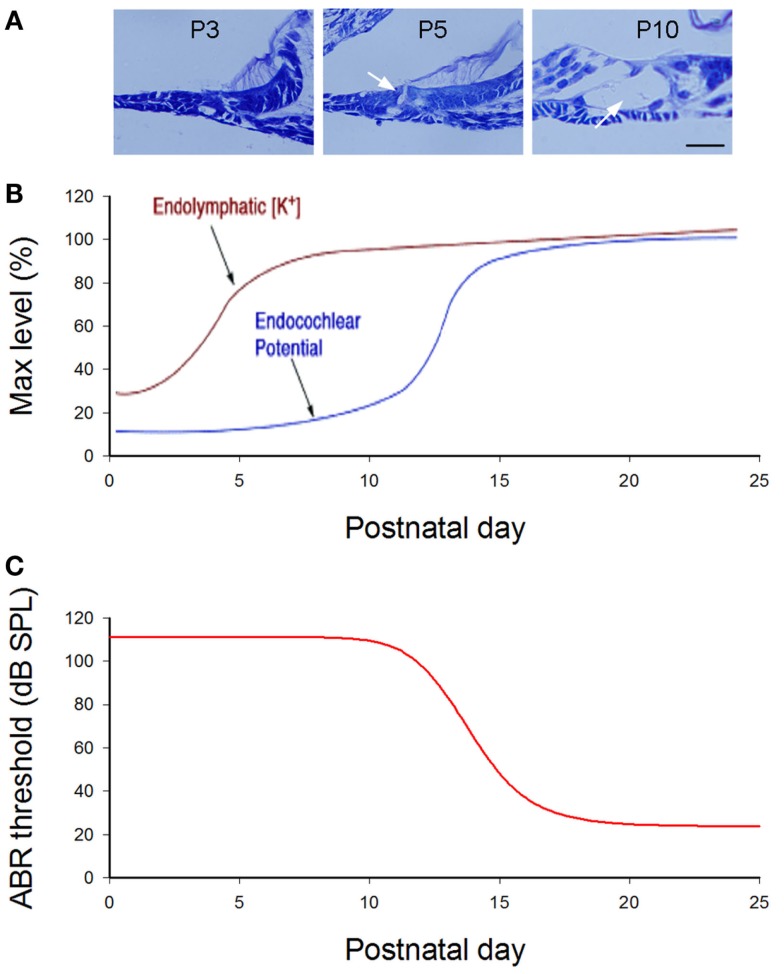
Cochlear postnatal development and functional maturation in mice. (A) Postnatal development of the cochlea. Arrows indicate that the cochlear tunnel starts to open at postnatal day 5 (P5) and fully opens at P10. (B) Postnatal developments of endocochlear potential (EP) and [K+]. Modified from Hibino et al. (2004). (C) Hearing maturation in mice. ABR thresholds dramatically drop at P11–16 and reach normal levels around P20. Modified from Liang et al. (2012).